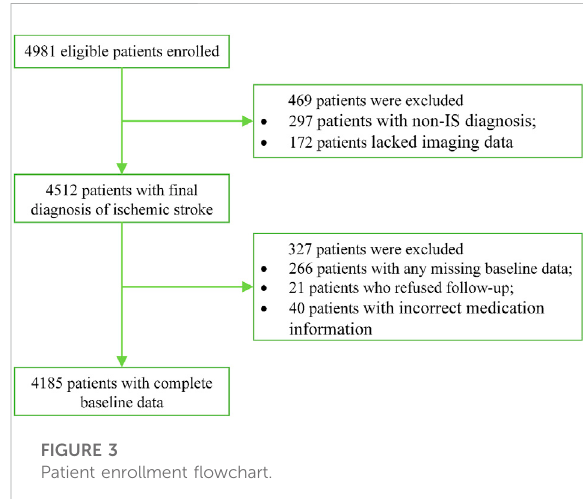
FIGURE 3 Patient enrollment fl owchart.